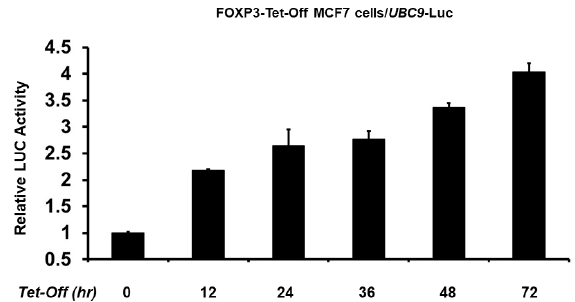
Figure 3. FOXP3 enhances UBC9 transcription in FOXP3-Tet-off MCF7 cells. FOXP3-Tet-off MCF7